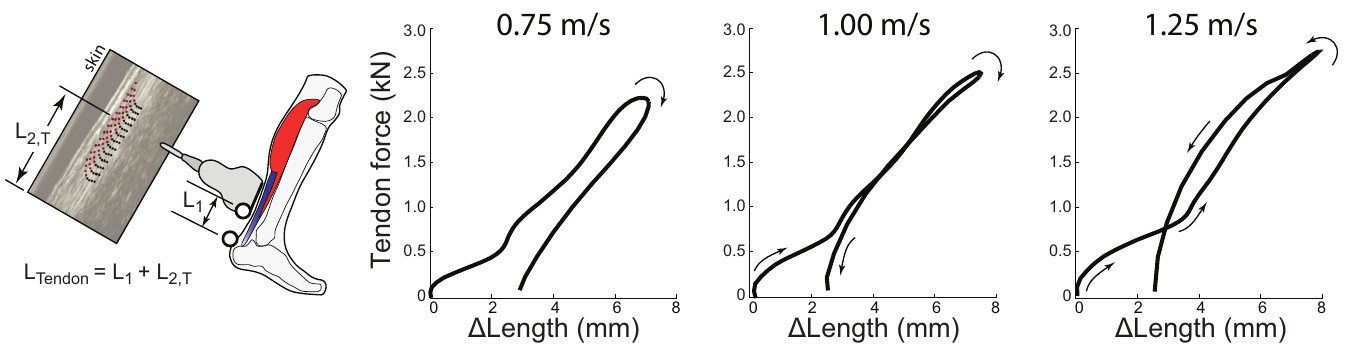
Fig 3. Direct Tendon estimation method and tendon work loops during walking. Left: The Direct Tendon method estimates tendon length changesby summing the instantaneous positionof the ultrasoundtransducer with respect to the tendon’sinsertion, L 1 , and the averagelocal displacements of tendon tissue within the transducer’s field of view, L 2, T , basedon speckle- tracking analysis. In this method the ultrasound transducer is positionedover the Achilles free tendon, distal to the soleus MTJ. Right: This Direct Tendon method yields negative tendonwork loops on average, for all walkingspeeds tested. Similar to trends observed in the Direct MTJ results, hysteresis losses estimated from the Direct Tendon method were also observed to decrease with increasing walkingspeed, from an averageof 33% at 0.75 m/s to 2% at 1.25 m/s. Average (inter-subject) mean results are depicted( N = 8).